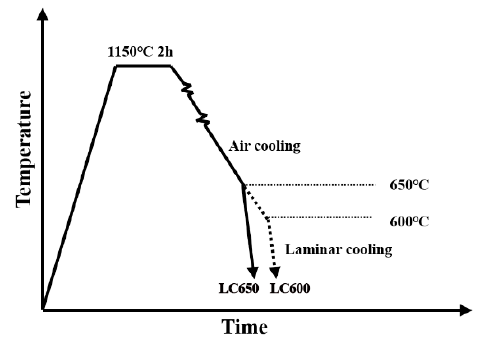
Figure 1. T hermo-mechanical controlled processing (TMCP) process flow chart of experimental